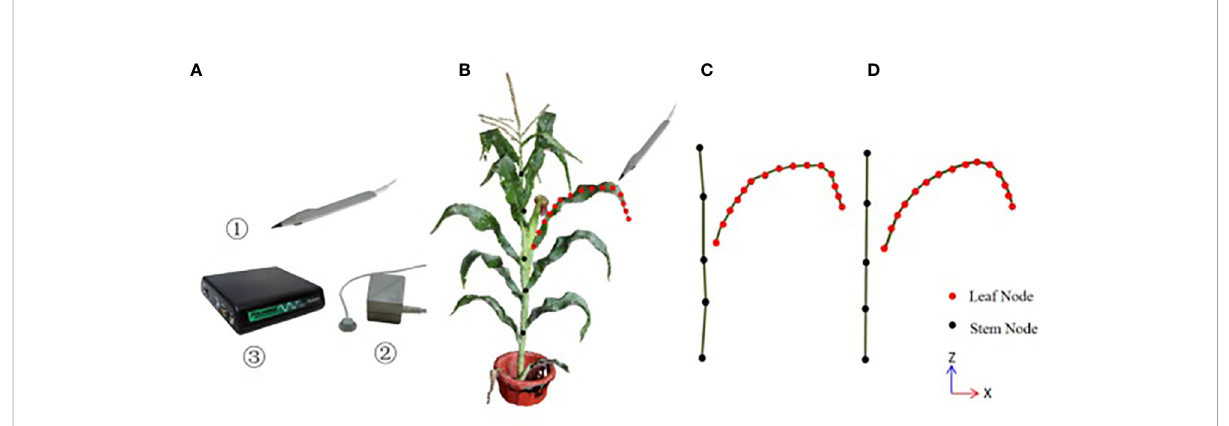
FIGURE 1 The three-dimensional digitizer device and the schematic diagram of three-dimensional digital key point acquisition of corn ear leaf (A) Polhemus FASTSCAN, ① the probe pen, ② the electromagnetic emission locator, ③ the position calculation unit; (B) the acquisition rules of the digitizer, (C) the topological relationship of stalk node key points and leaf midrib key points collected by the digitizer, (D) the results of the key points of stalk nodes and leaf midribs after smooth correction by the method in this